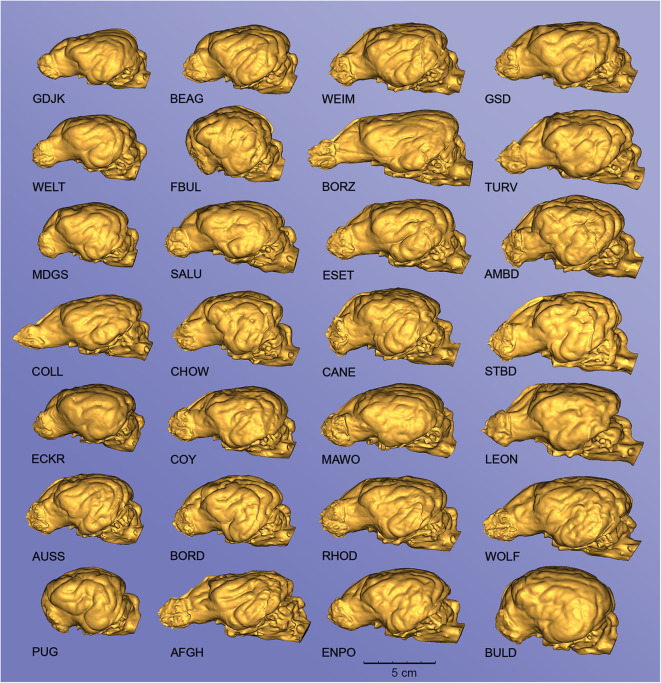
Endocasts from different canine specimens, showing the diversity of surface morphology. Left lateral view. GDJK, Golden jackal; BEAG, Beagle; WEIM, Weimaraner; GSD, German shepherd dog; WELT, Welsh terrier; FBUL, French bulldog; BORZ, Borzoi; TURV, Belgian shepherd dog (Tervueren); MDGS, Medium German spitz; SALU, Saluki; ESET, English setter; AMBD, American bulldog; COLL, Collie; CHOW, Chow chow; CANE, Cane corso; STBD, Saint Bernard; ECKR, English cocker spaniel; COY, Coyote; MAWO, Maned wolf; LEON, Leonberger; AUSS, Australian shepherd; BORD, Border collie; RHOD, Rhodesian ridgeback; WOLF, Gray wolf; PUG, Pug; AFGH, Afghan hound; ENPO, English pointer; BULD, English bulldog. The endocasts are grouped into columns according to an increasing total volume [thus the top left endocast (GJDK) represents the smallest endocast, and the bottom right (BULD) has the largest volume].